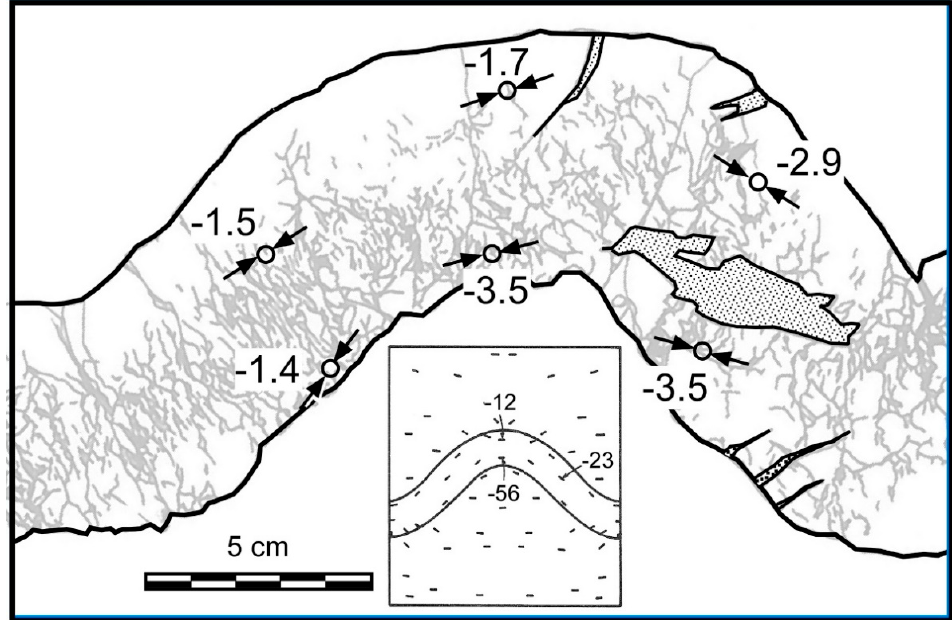
Figure 5. Comparison between calcite twin strains in a portion of the medium-dip fold layer, modified from [9] and the inset finite-element buckle fold model [8]. Both show shortening strains (negative) in percent. In the field example, arrows are maximum shortening directions in the plane of section, shaded areas are extension fractures filled with secondary calcite, and pale gray lines are stylolites. Every stylolite shown truncates a fossil somewhere along its length. In the inset model [8,9], short lines are principal shortening directions with magnitudes provided by Jim Dieterich [21]. Strains in the model are about an order of magnitude larger than in the field example.